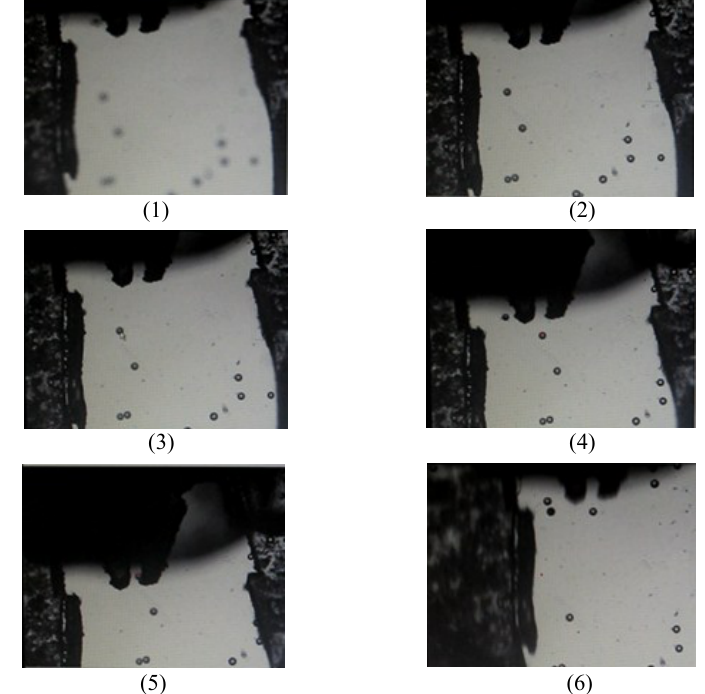
Figure 14. Results of tracking and gripping particle in 3-D space: ( 1 ) beginning of global searching for coarse adjustment; ( 2 ) finishing autofocus adjustment; ( 3 ) identifying particle by clicking mouse; ( 4 ) approaching particle; ( 5 ) gripping particle; and ( 6 ) releasing particle after completion of gripping and transporting particle.